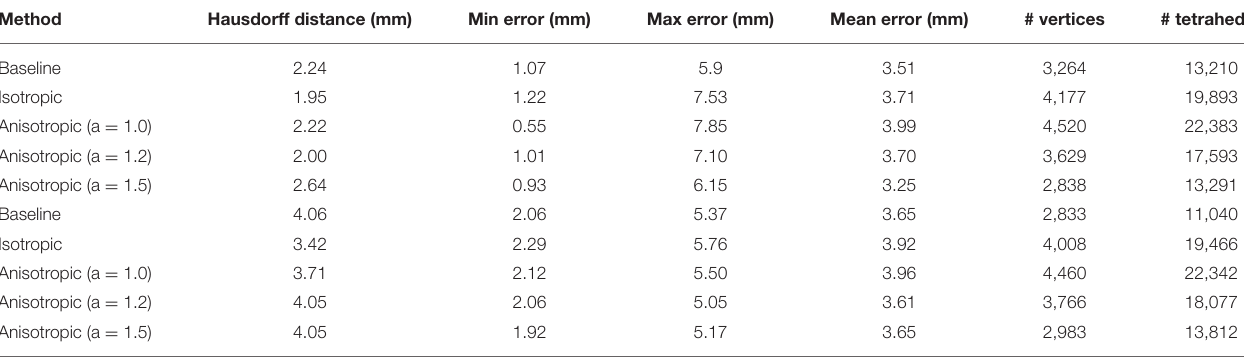
TABLE 6 | Effects of applying mesh adaptation at each iteration of A-PBNRR.